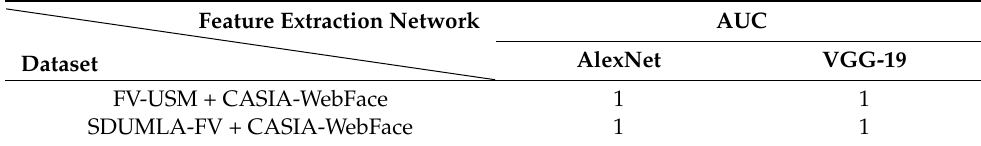
Table 6. AUC summary of different datasets under different feature extraction networks.